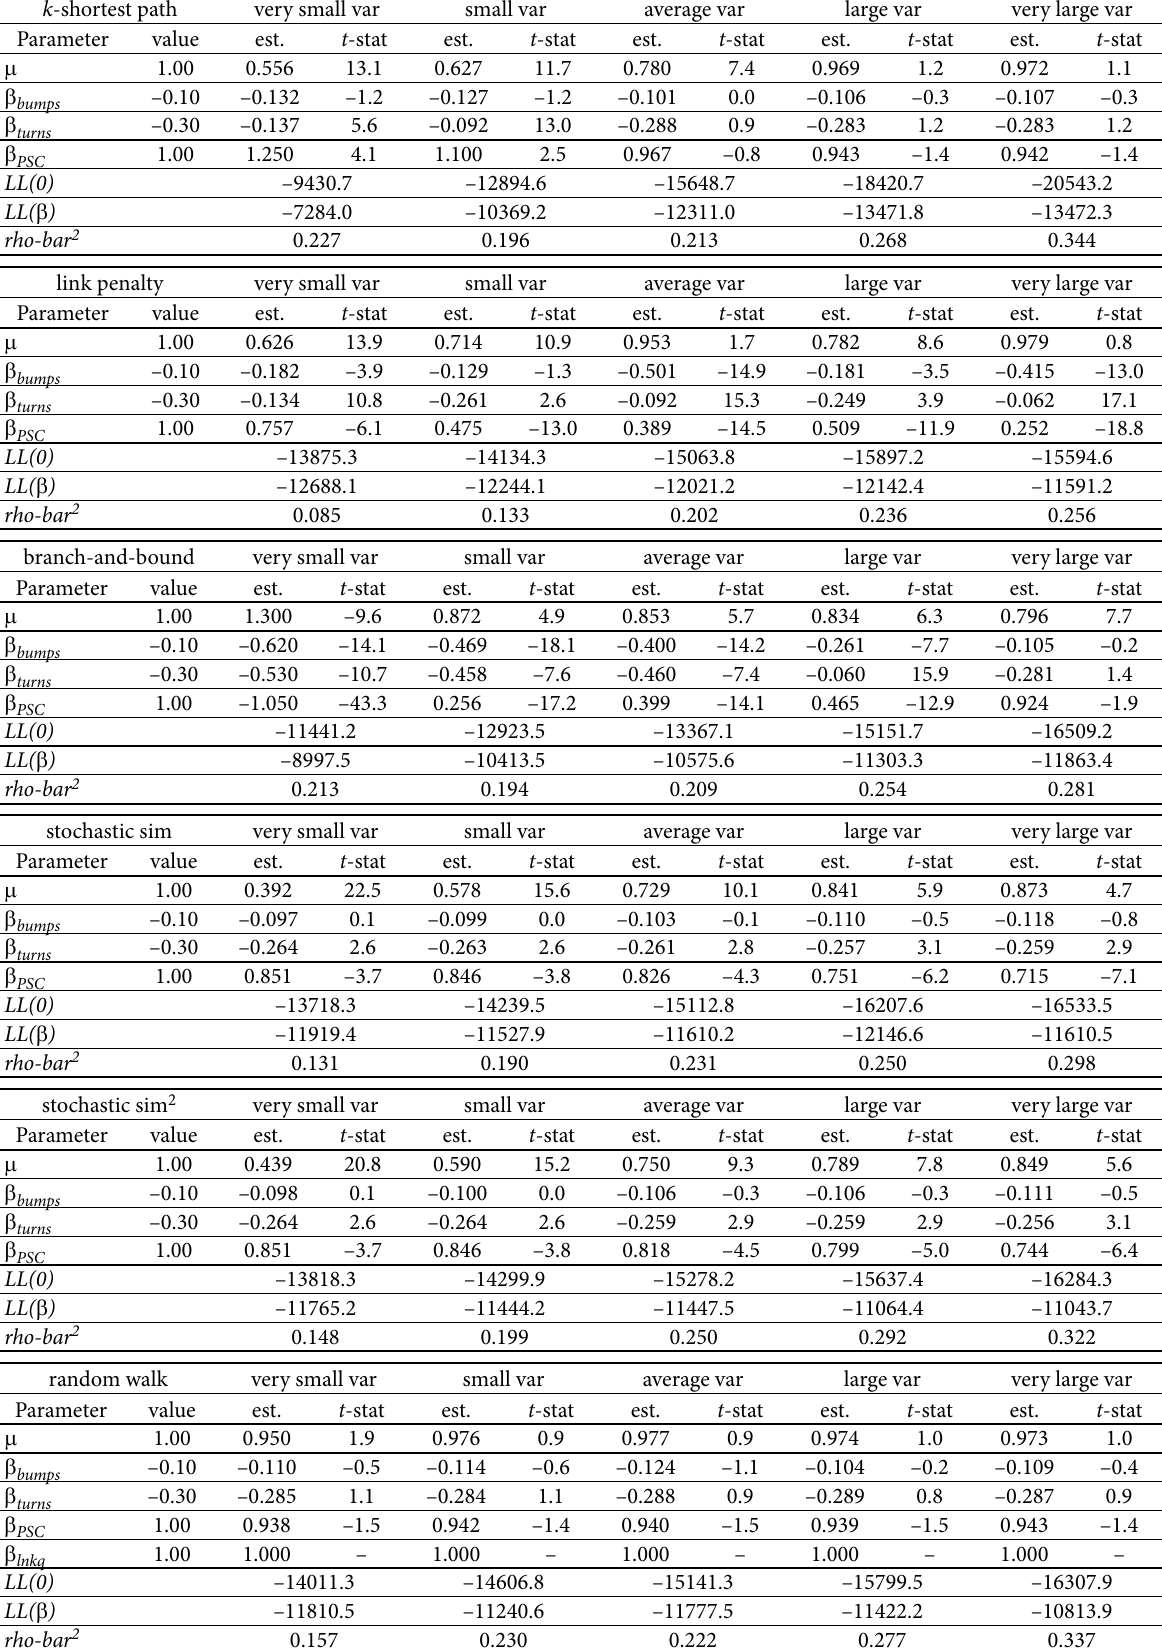
Table 5. Example of model estimates for generated choice sets from different path generation